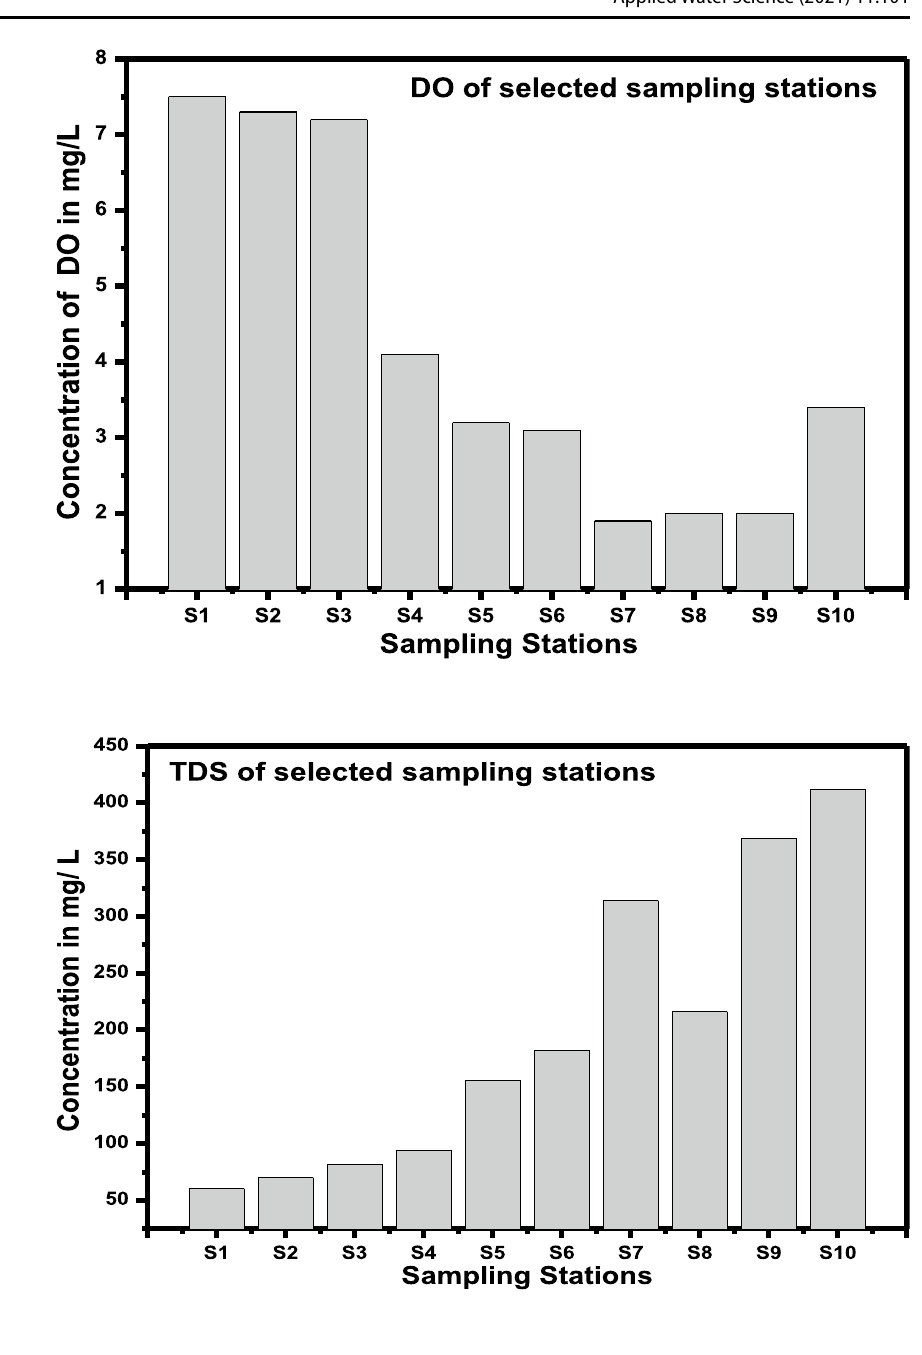
Fig. 4 DO of selected sampling stations